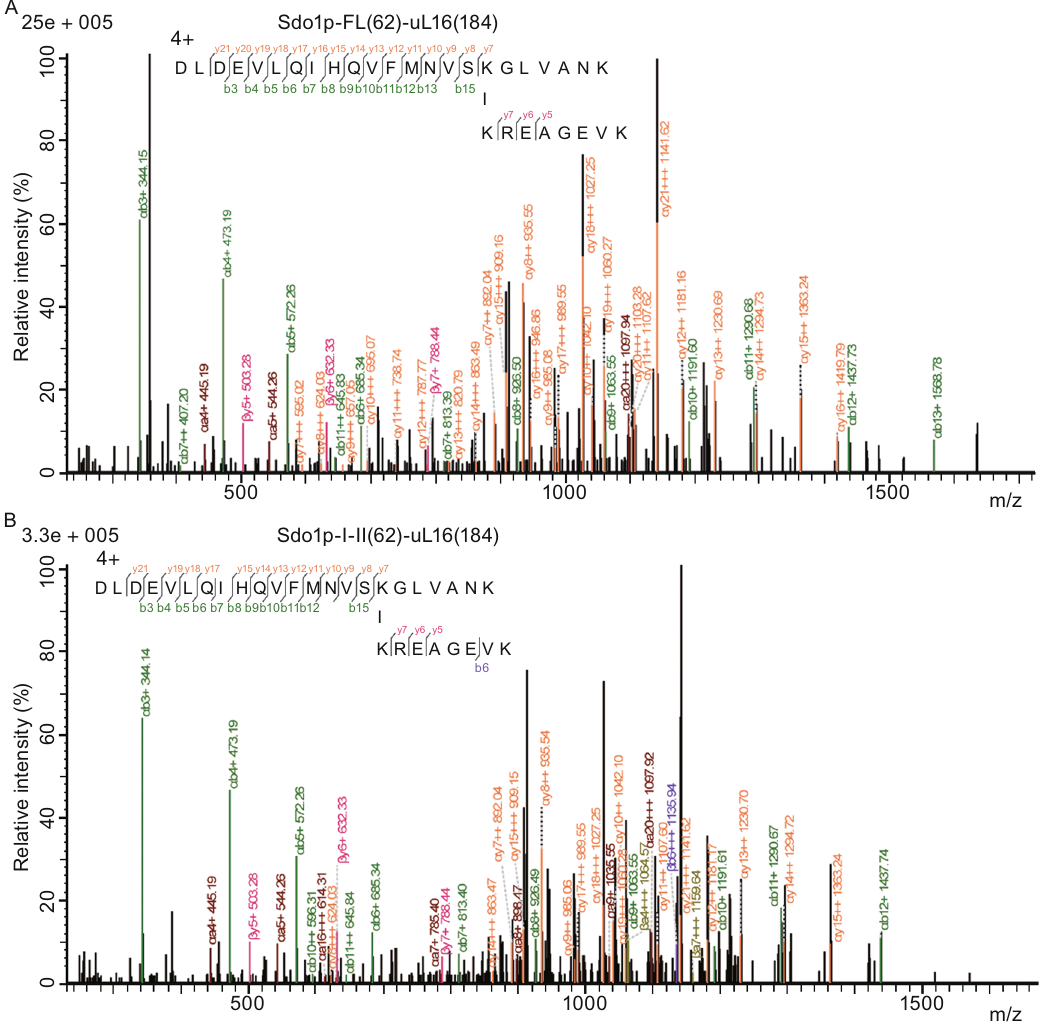
Figure 5. Crosslinking of Sdo1p with uL16 identi fi ed in CX-MS. (A) Representative MS spectra of the cross-linked peptides between Sdo1p and uL16 detected in the samples of the 60S-Sdo1p-FL (full-length) complex (A), the 60S-Sdo1p-I-II (Domain I-II) complex (B). Primary sequences of linked peptides are shown, with sites of cleavages labelled in different colors in both the sequences and spectra. 4+ or 3+ indicates the charge of the cross-linked